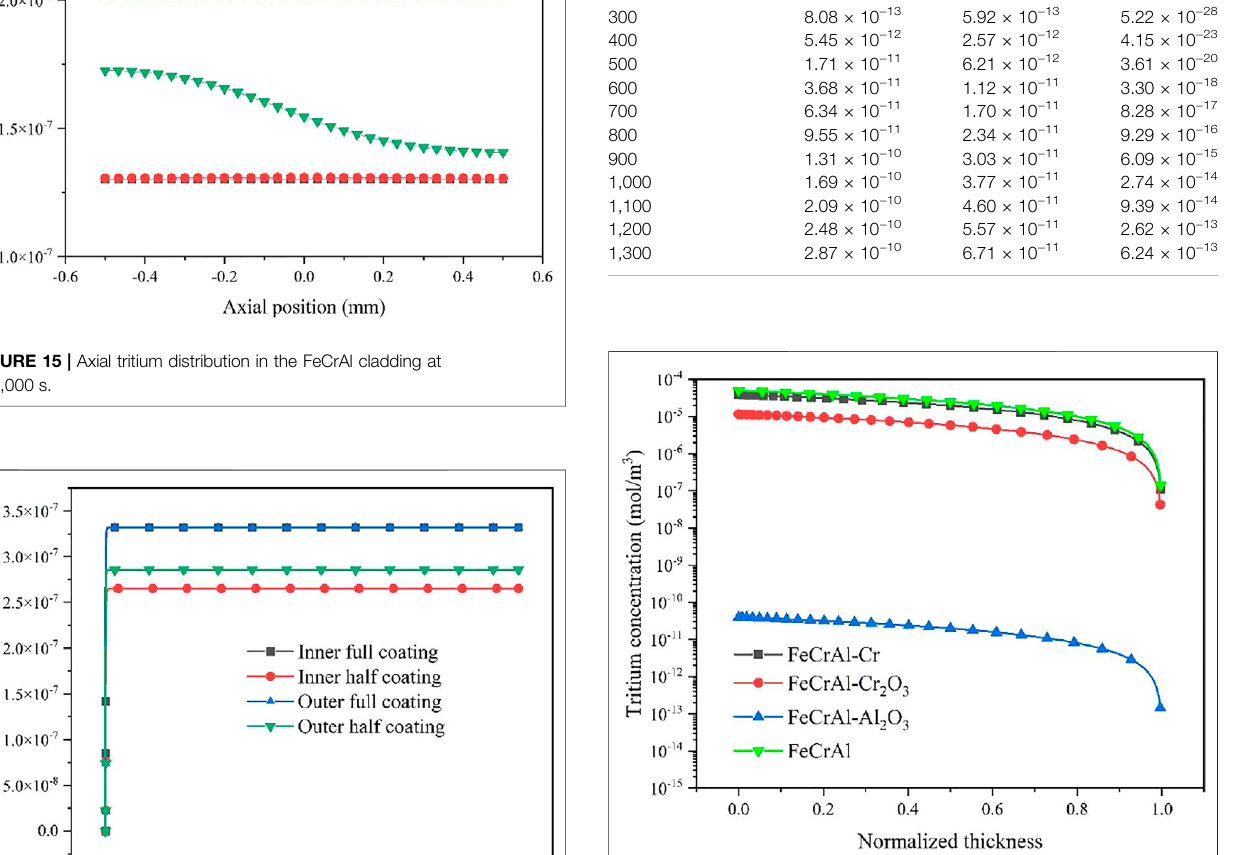
FIGURE 17 | Tritium distribution in the FeCrAl cladding with different coatings under a steady state